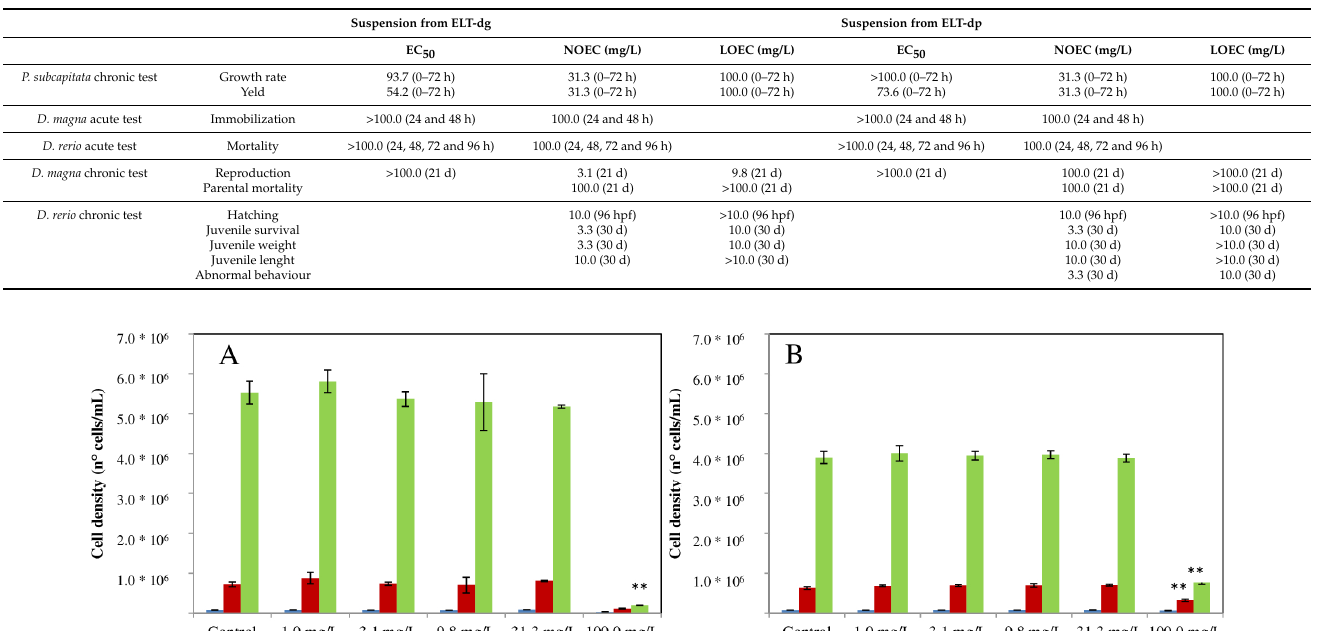
Table 1. Values of EC 50 , NOEC and LOEC for the main tested end points obtained by the different OECD tests for both ELT-dg and ELT-dp suspensions. For EC 50 determination, the following con- ditions were evaluated: the 95% confidence interval did not contain zero and was not overly wide, the 95% confidence interval for the predicted mean did not contain the control mean, there was no significant lack of fit of regression model to the data. If the above conditions were not satisfied, the NOEC approach was used.